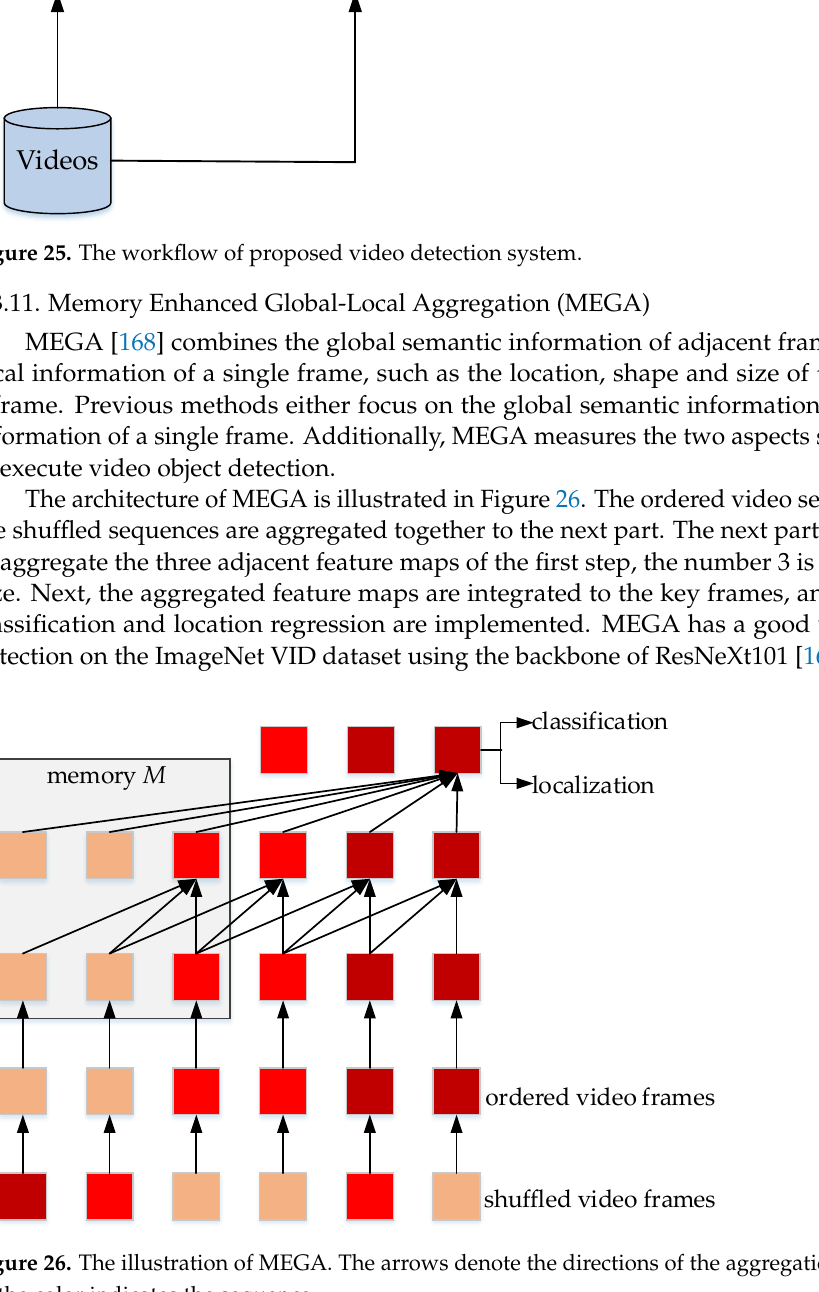
Figure 27. The illumination of TSM. TSM shifts the feature map tensor along the temporal sequence, forward or backward. The empty positions are filled with zeros.